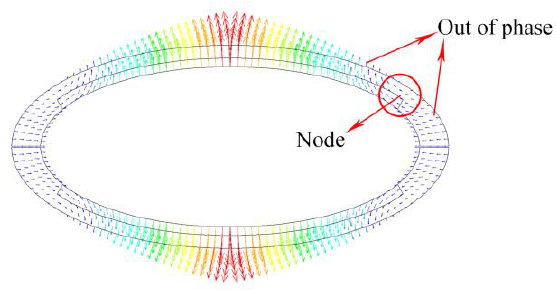
Figure 3. The first flexural vibration mode shapes of conformal driving Class IV FT.